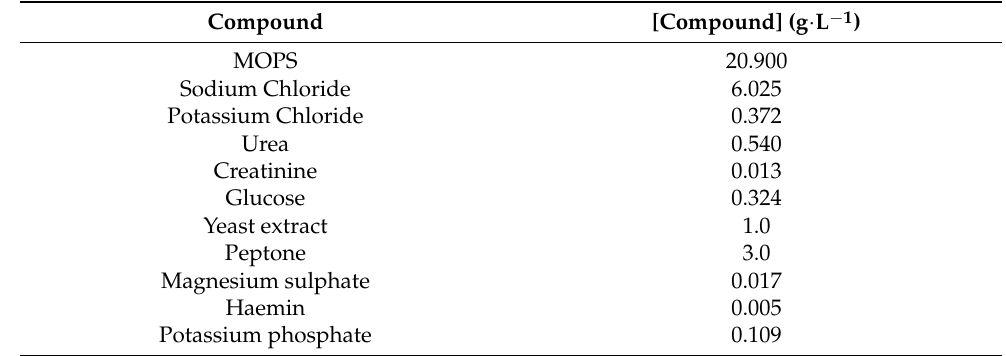
Table 2. Artificial wound exudate composition according to Oates et al. [37]. The pH of the solution was adjusted to 7 using NaOH or